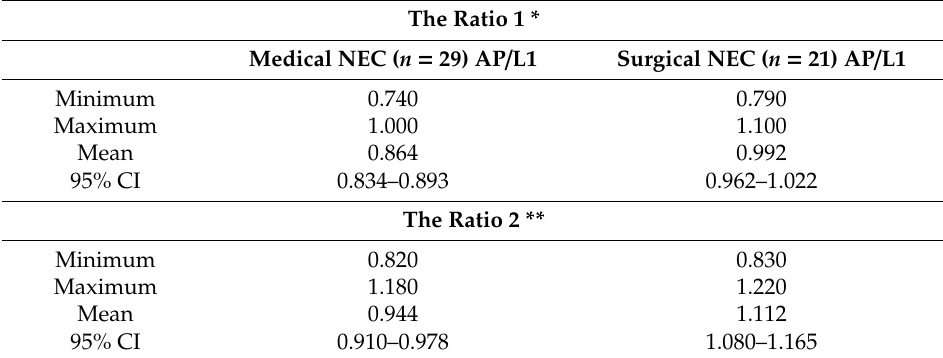
Table 1. The comparisons of the assessed parameters on the abdominal radiographs in the preterm infants with medical and surgical